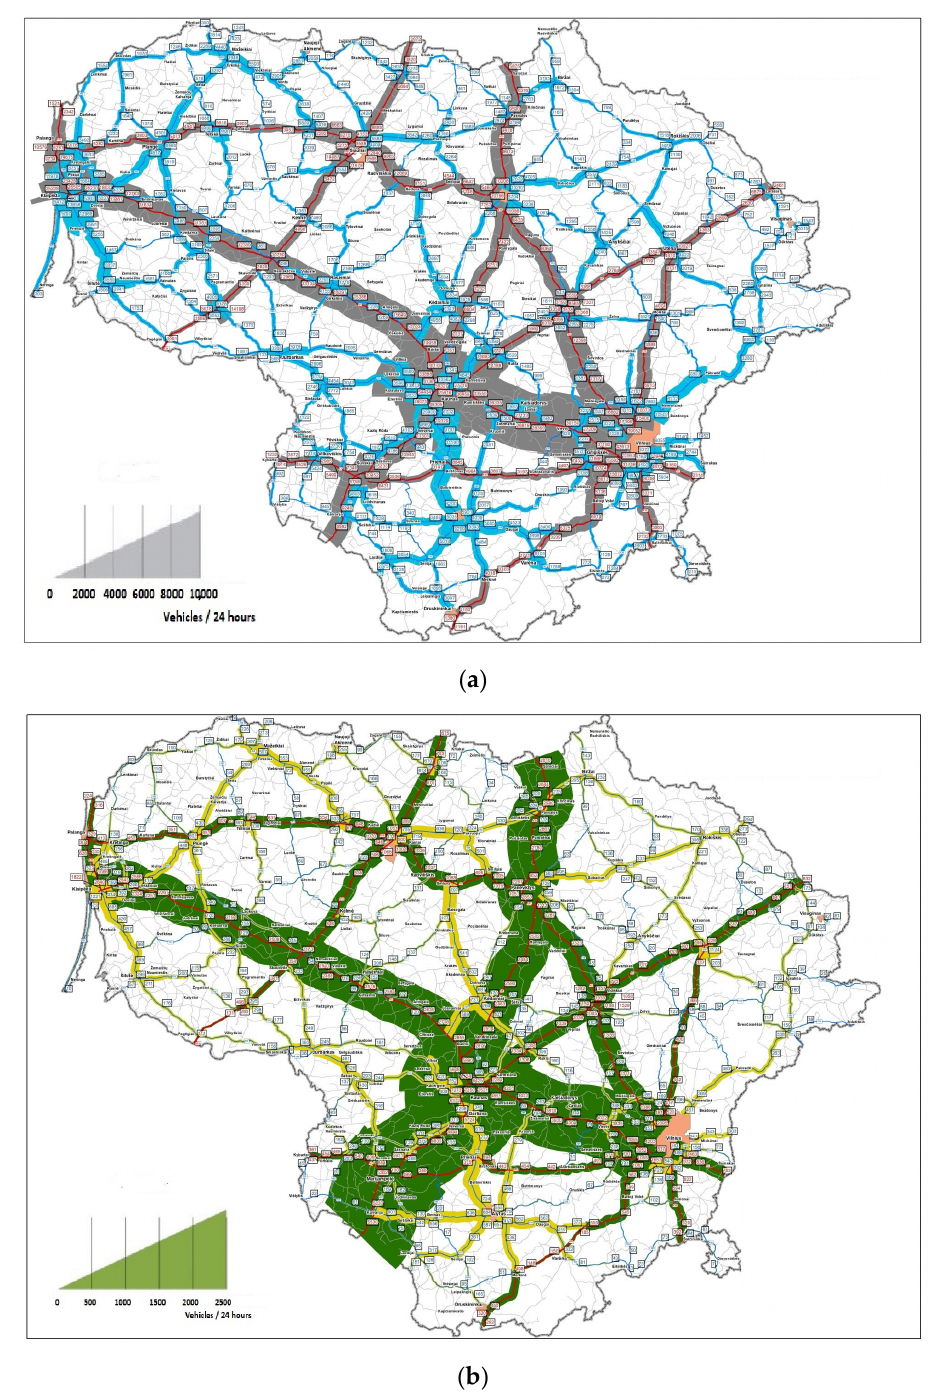
Figure 1. Change of the average annual daily traffic intensity in Via Baltica transport corridor: ( a ) total intensity; ( b ) trucks intensity .